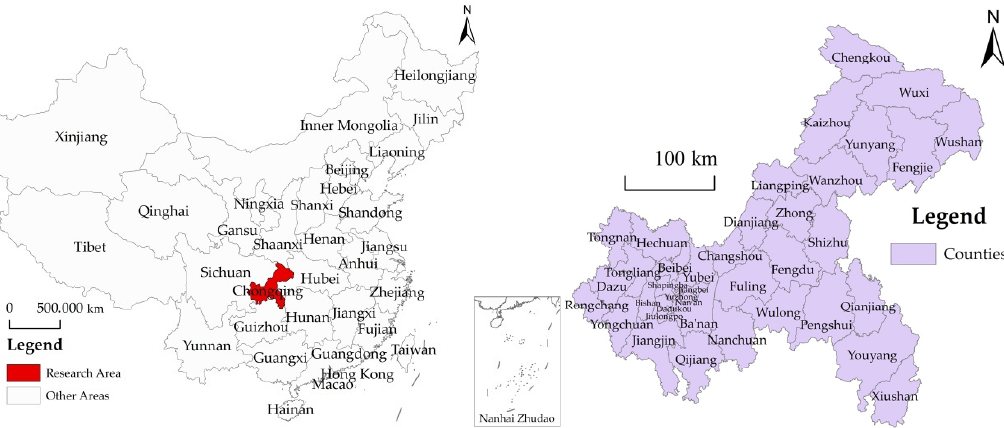
Figure 1. The geographical location and administrative division of Chongqing Municipality.